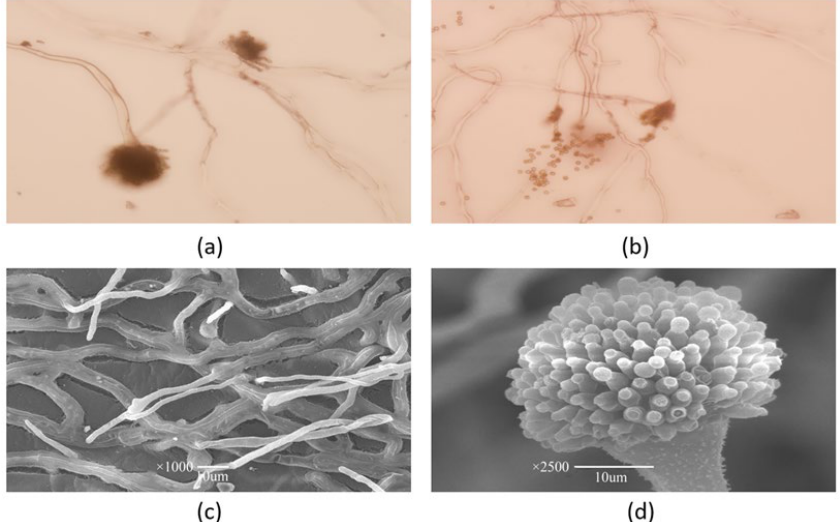
Figure 1. ( a ) The sporangia of SY fx2 13.2 fungus under the optical microscope at 800-times magnification; ( b ) spores of SY fx2 13.2 fungus under the optical microscope at 800-times magnification; ( c ) 1000-times magnification of mycelia under the scanning electron microscope; ( d ) 2500-times magnification of Conidial head under the scanning electron microscope.